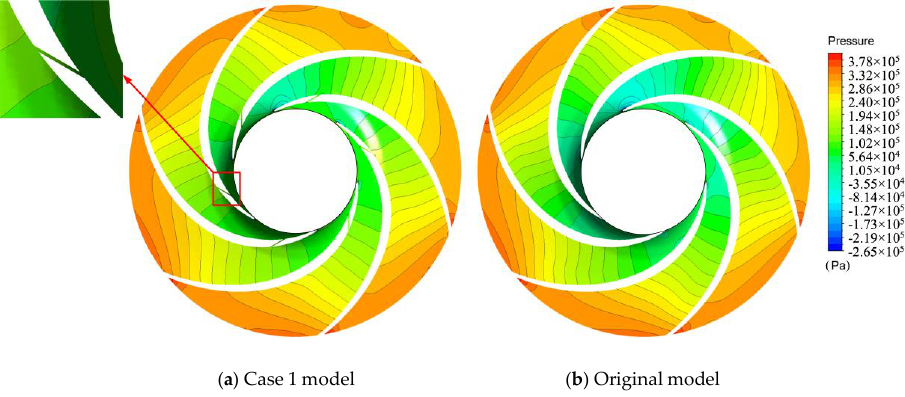
Figure 14. Static pressure distribution in the middle plane of the blade flow channel at 0.6 Q .